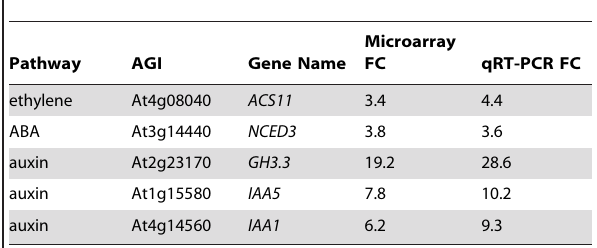
Table 1. Quality control of microarray